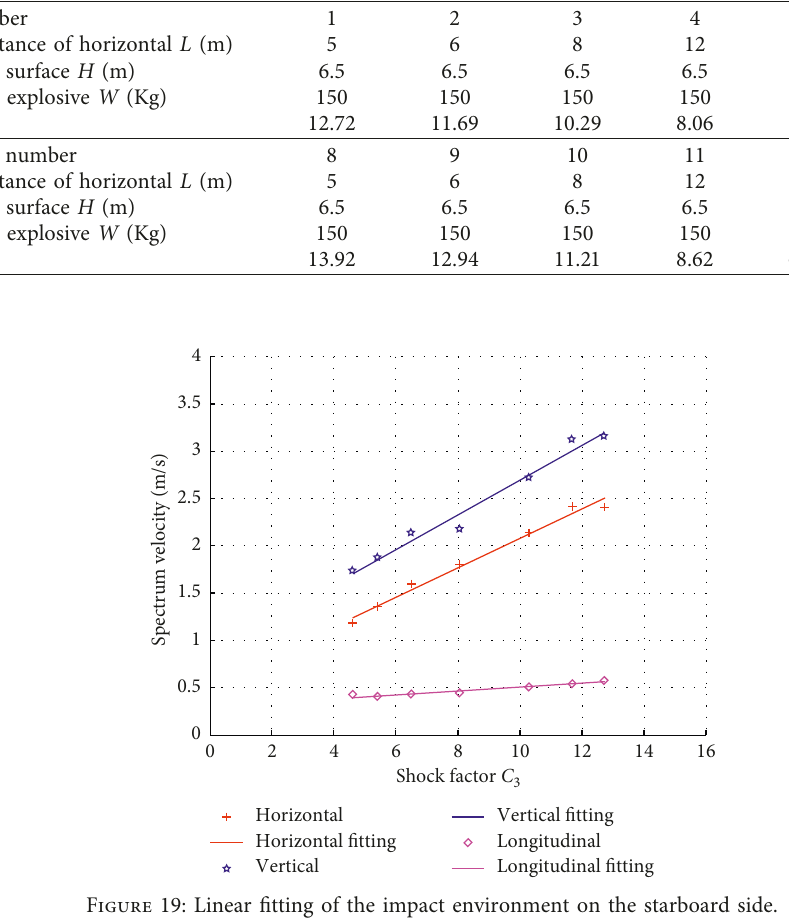
Table 8: Condition setting of impact environment forecast.